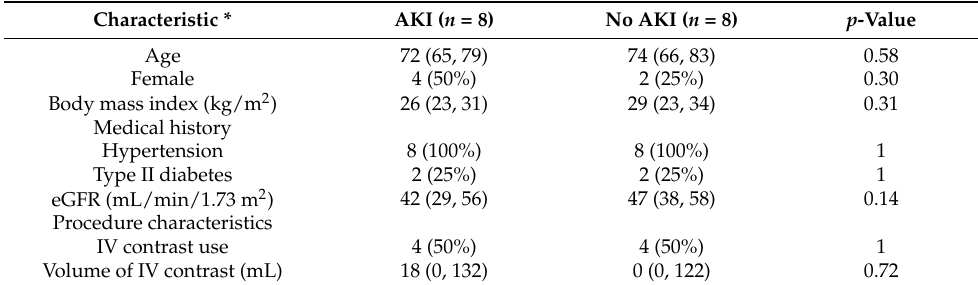
Table 2. Postoperative cohort